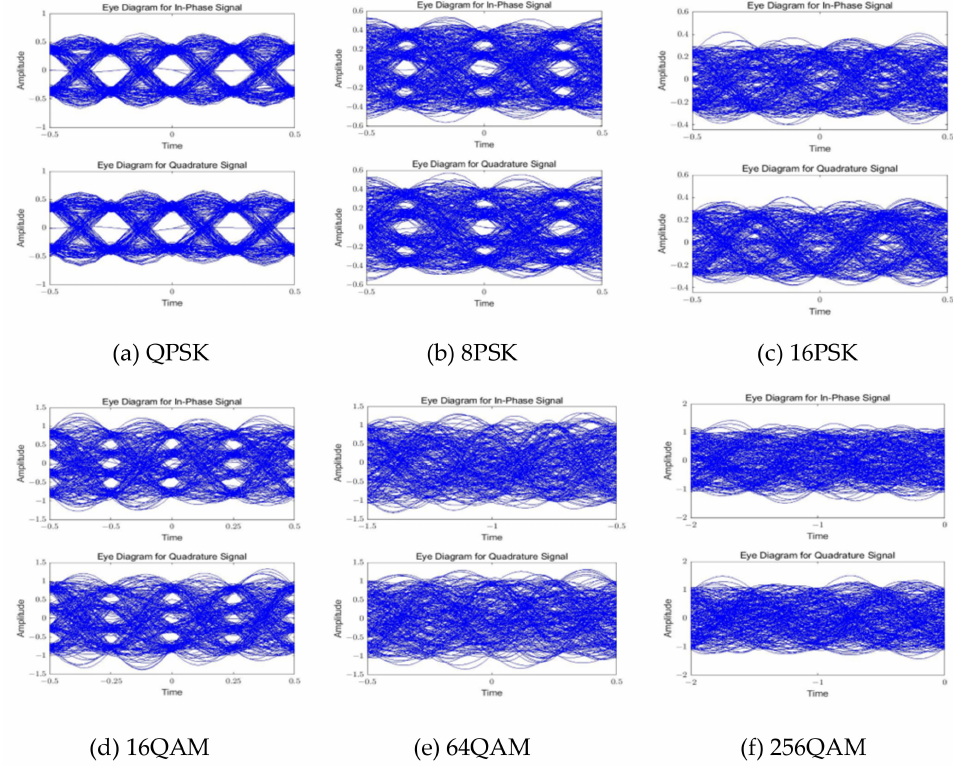
Figure 8. Eye diagram of modulated